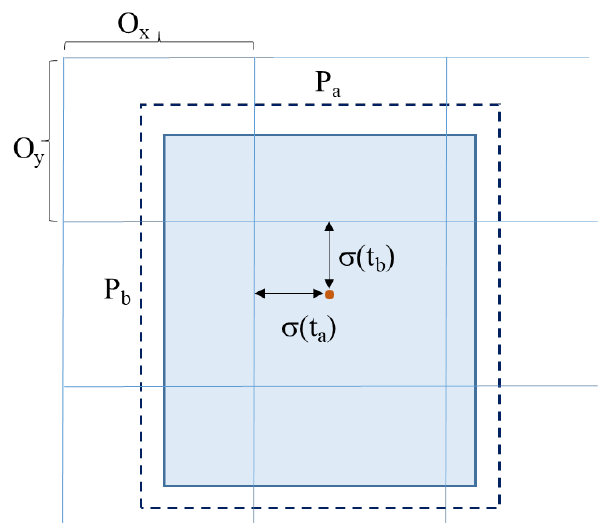
Figure 4. Network structure diagram of YOLOv3.